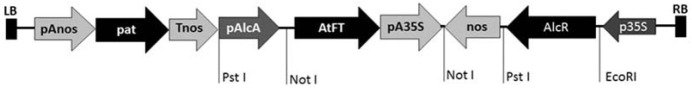
Schematic representation of the transformation vector.Arabidopsis FT cDNA was inserted into the construct through Gateway cloning. pAnos, nopaline synthase polyadenylation signal; pat, phosphinothricin acetyltransferase; Tnos, terminator of nopaline synthase; pAlcA, promoter of alcohol dehydrogenase I (Adh-I) encoded by the alcA gene; FT cDNA, cDNA of Flowering Locus (FT) gene; pA35S, polyadenylation sequence of Cauliflower mosaic virus 35S gene; nos, nopaline synthase terminator; ALCR, transcriptional factor which binds to AlcA promoter; p35S, Cauliflower Mosaic Virus 35S promoter; LB, left border; RB, right border.